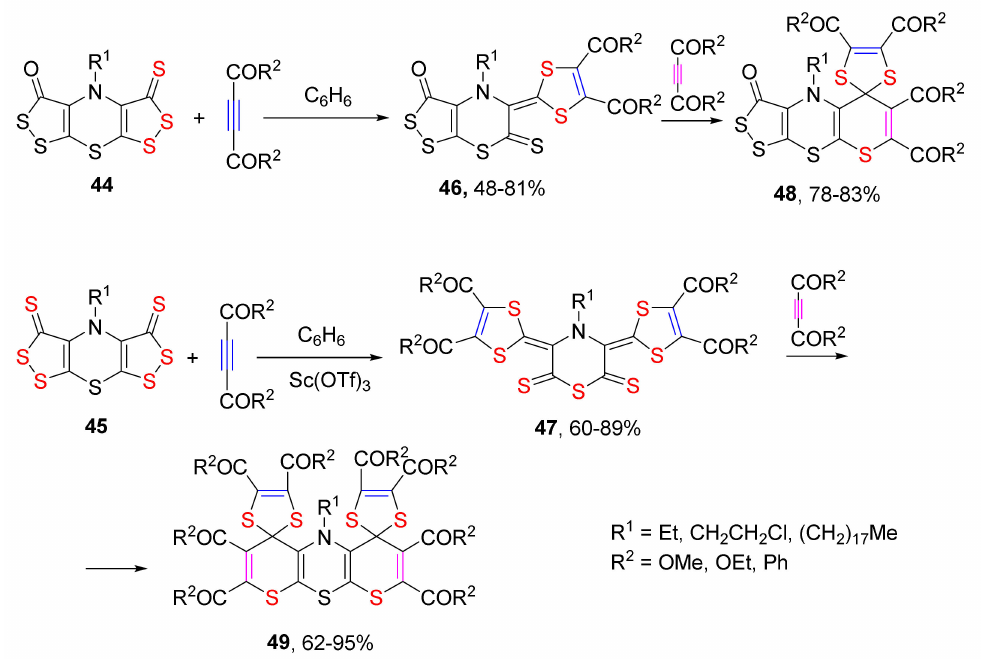
Scheme 38. Reaction of bis-dithiolothiazines 44 and 45 with